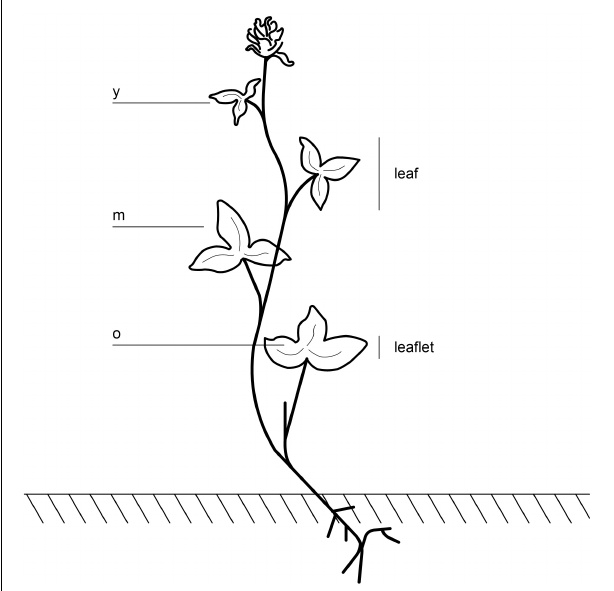
FIGURE 1 | Sampling on red clover plants was performed on the youngest leaf, where three leaflets were fully emerged (y), on the three leaflets of the oldest leaf (o), and on three different mature leaves, in total nine leaflets